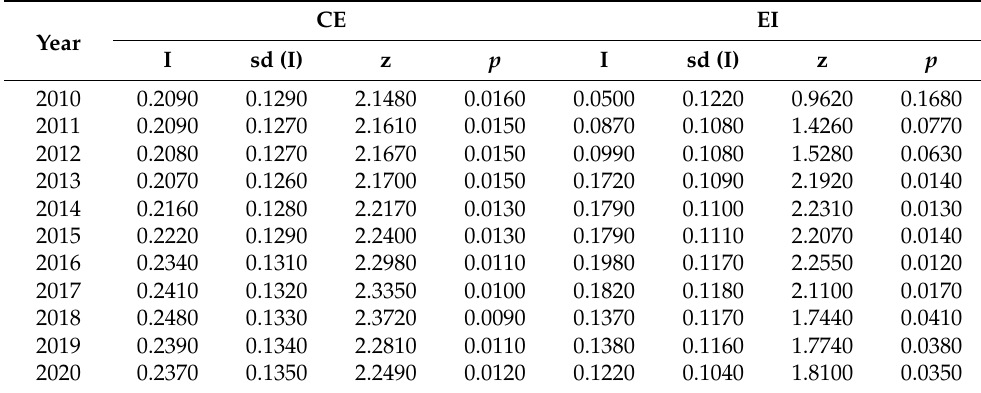
Table 5. Spatial correlation test of carbon emissions and energy